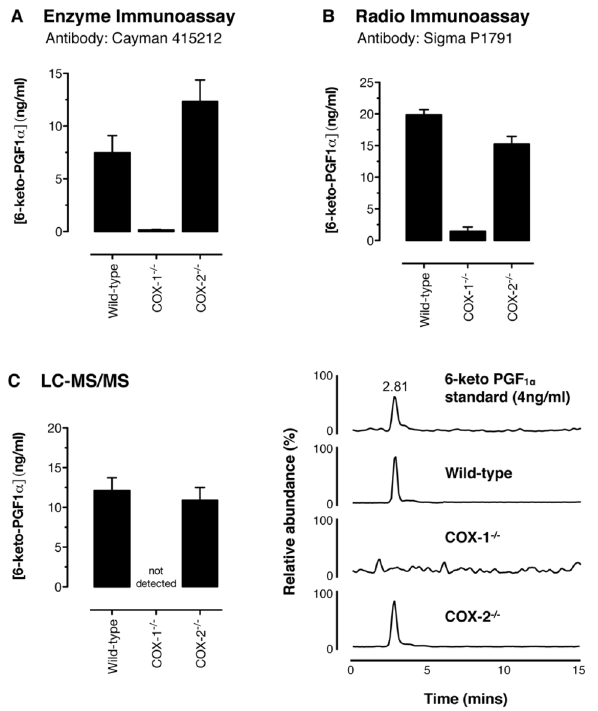
production in isolated mouse aorta; 1α